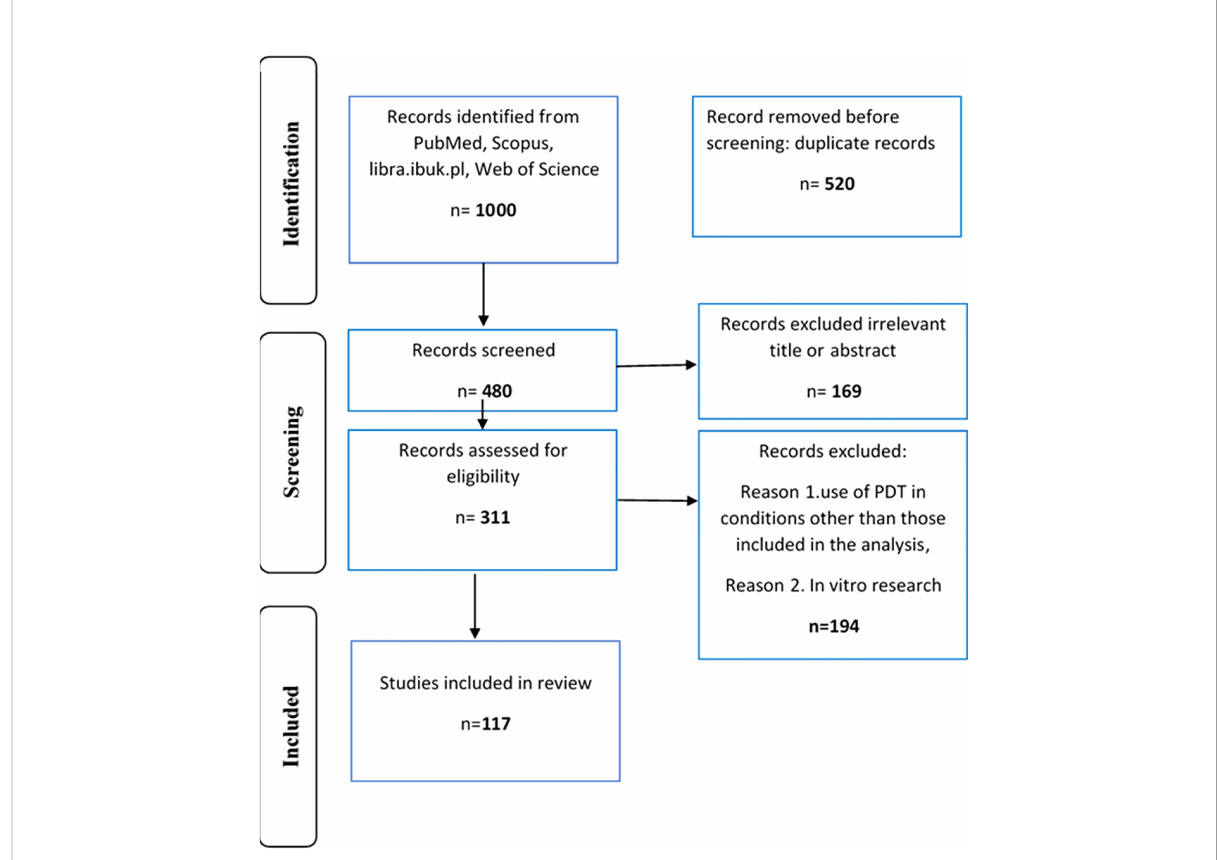
FIGURE 1 Diagram illustrating the procedure for analyzing the source